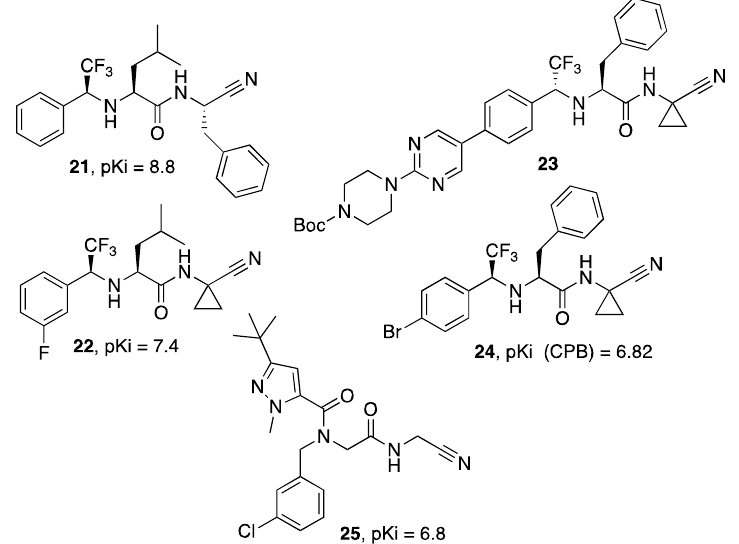
Figure 6. Structure of P2-trifluoroethylamine inhibitors ( 21–24 ) and the peptoid derivative ( 25 ).